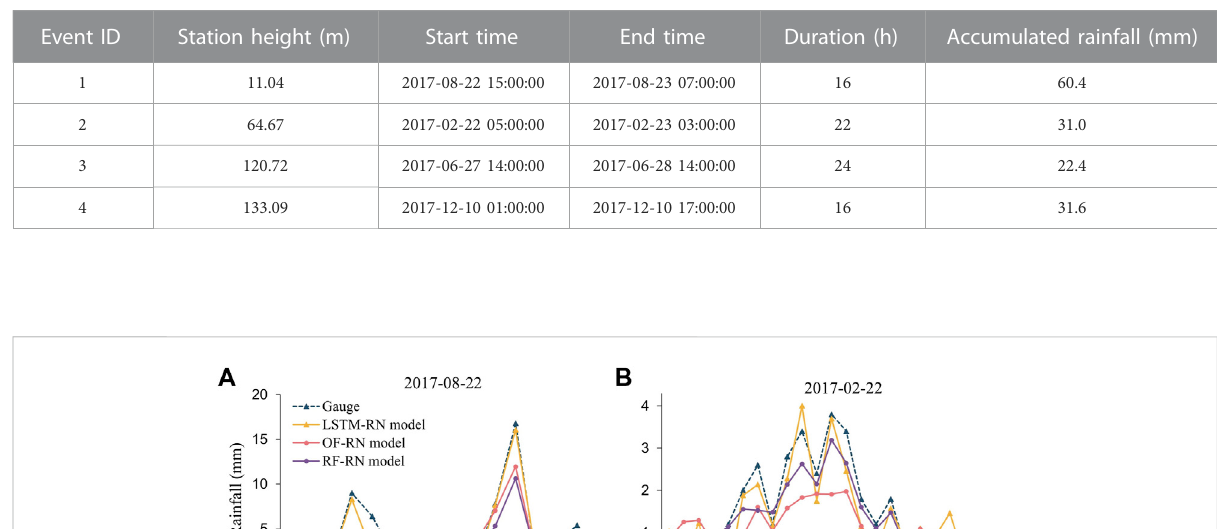
TABLE 3 Durations and accumulated rainfall of selected storm events.